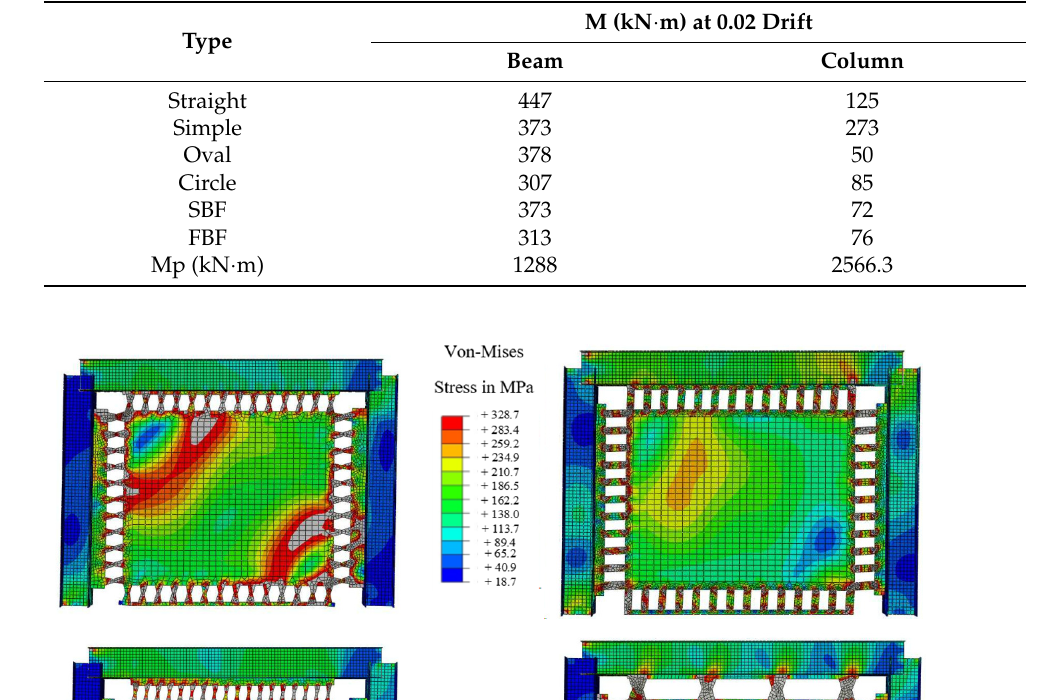
Table 8. The demand moment forces captured at the middle point of beam and column.